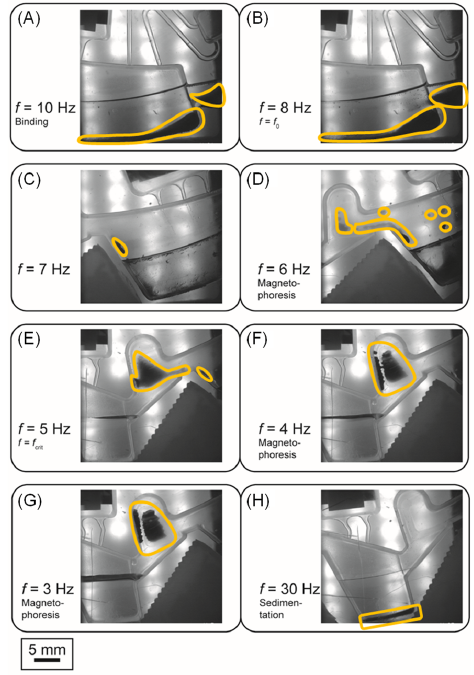
Figure 7. Stroboscopic images indicating the steps of continuous rotation magnetophoresis. The yel ‐ low frame marks the bead cluster. ( A ): Magnetic beads are rehydrated and remain in the